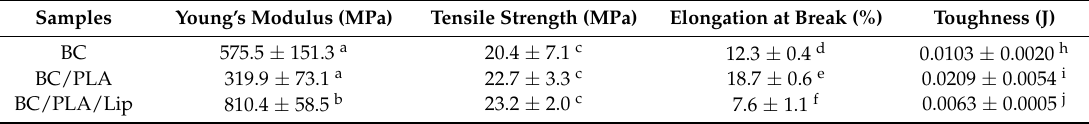
Figure 7. Moisture regain of BC, BC/PLA, and BC/PLA/Lip mats.